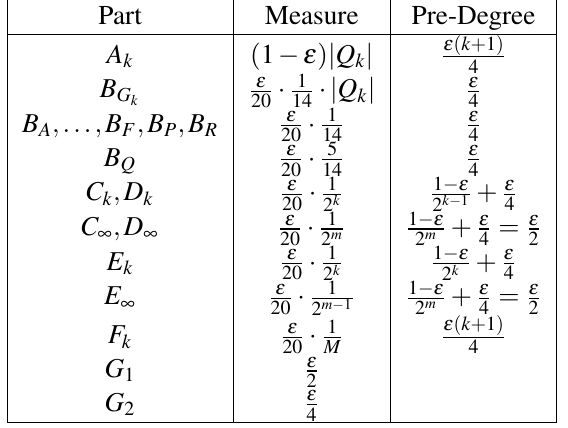
Figure 4: A sketch of the structure of the graphon W 0 between the parts contained in A ∗ and B G ∗ and the parts contained in C ∗ , D ∗ , E ∗ and F ∗ .